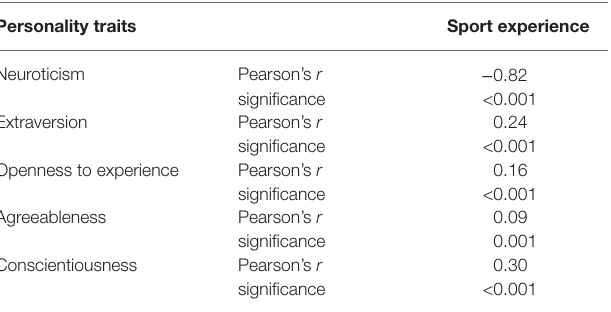
TABLE 2 | Coefficients of Pearson’s r correlation analyses between personality traits and sport experience among the surveyed athletes. Personality